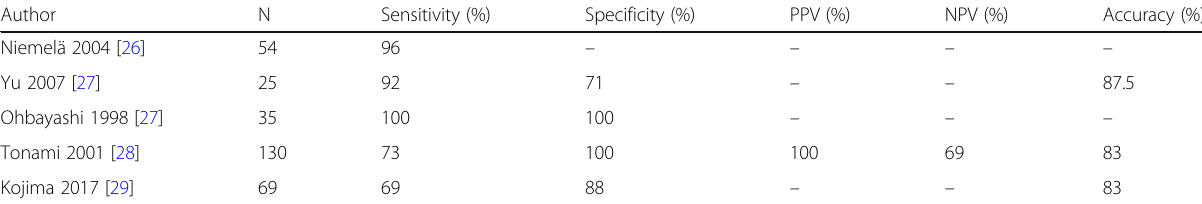
Table 3 Magnetic resonance sialography for the diagnosis of SS Author